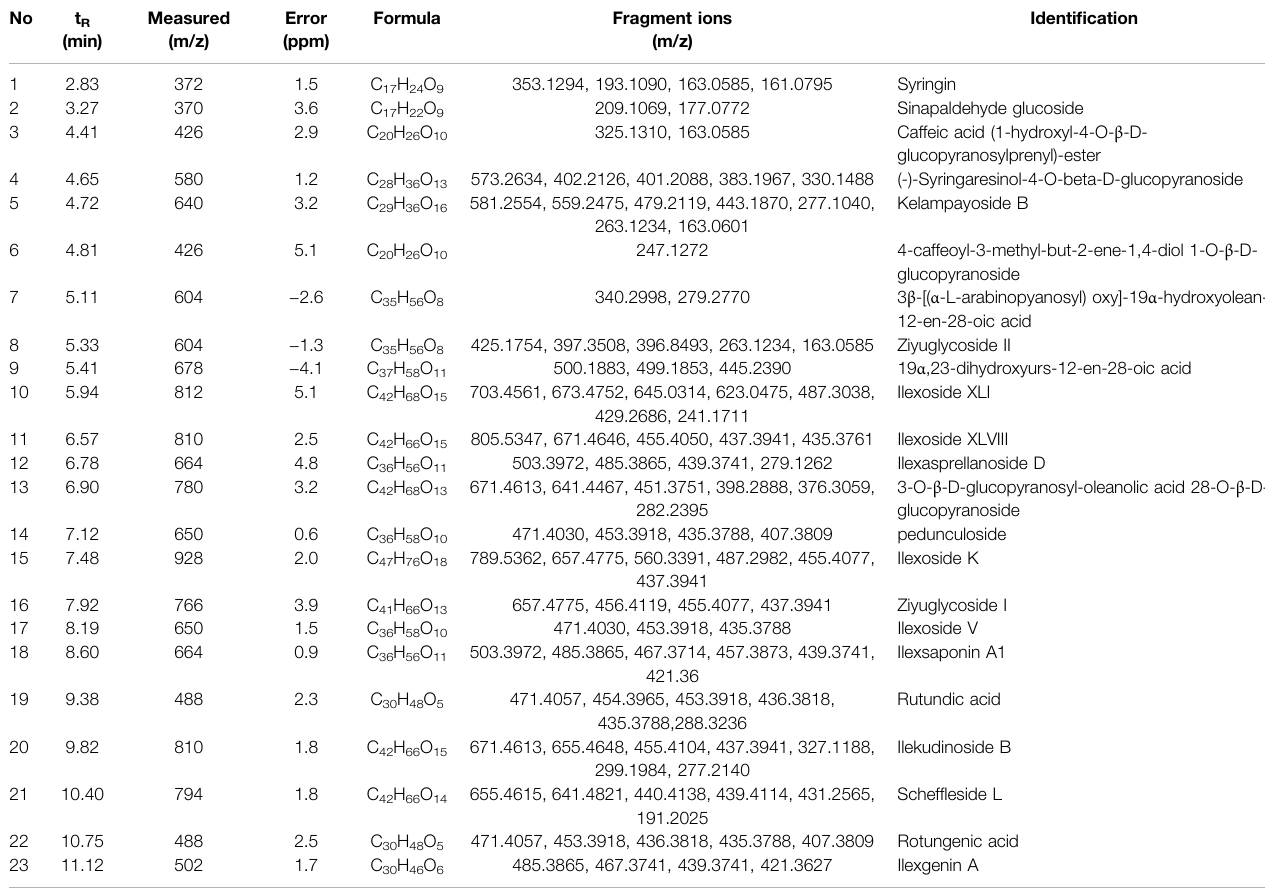
TABLE 2 | Main components of IR identi fi ed by